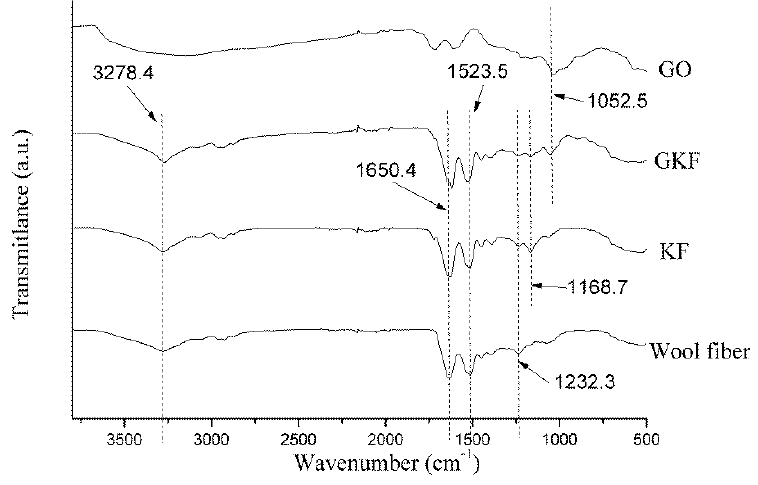
Figure 4. Raman spectra of wool fibers and regenerated keratin samples.